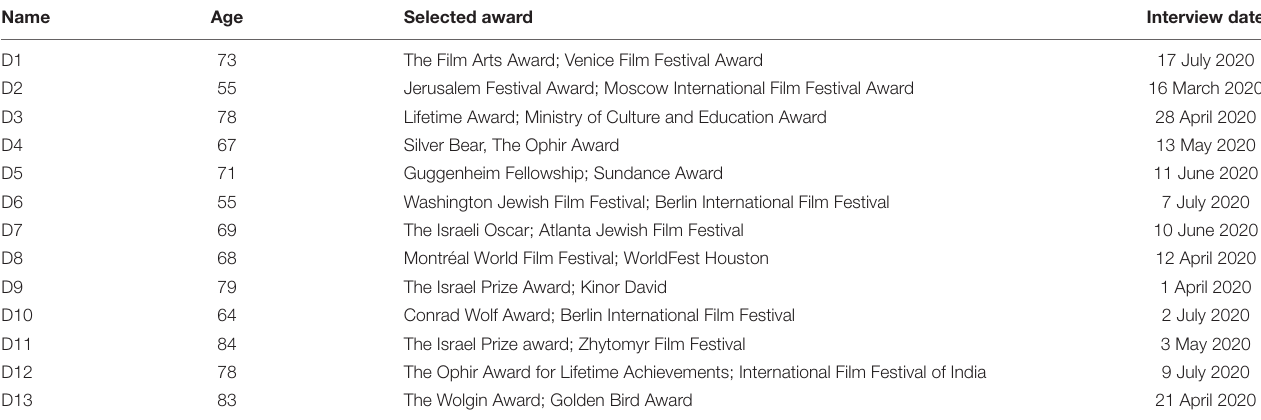
TABLE 1 | Directors by age and selected